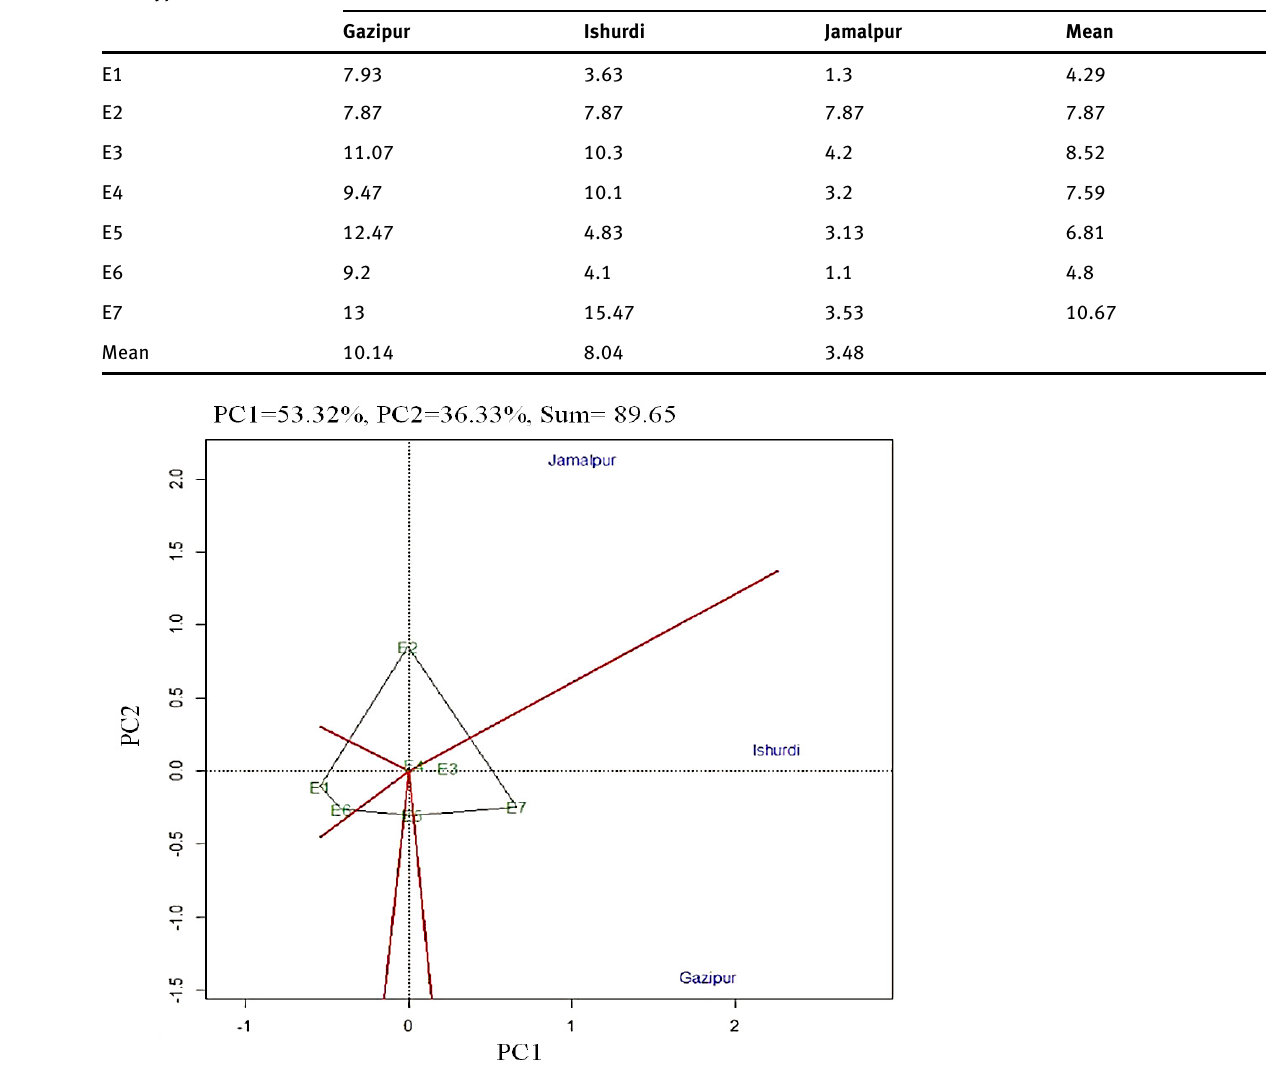
Figure 2: Polygon view of the GGE biplot to show which genotype better in which environment for grain yield of